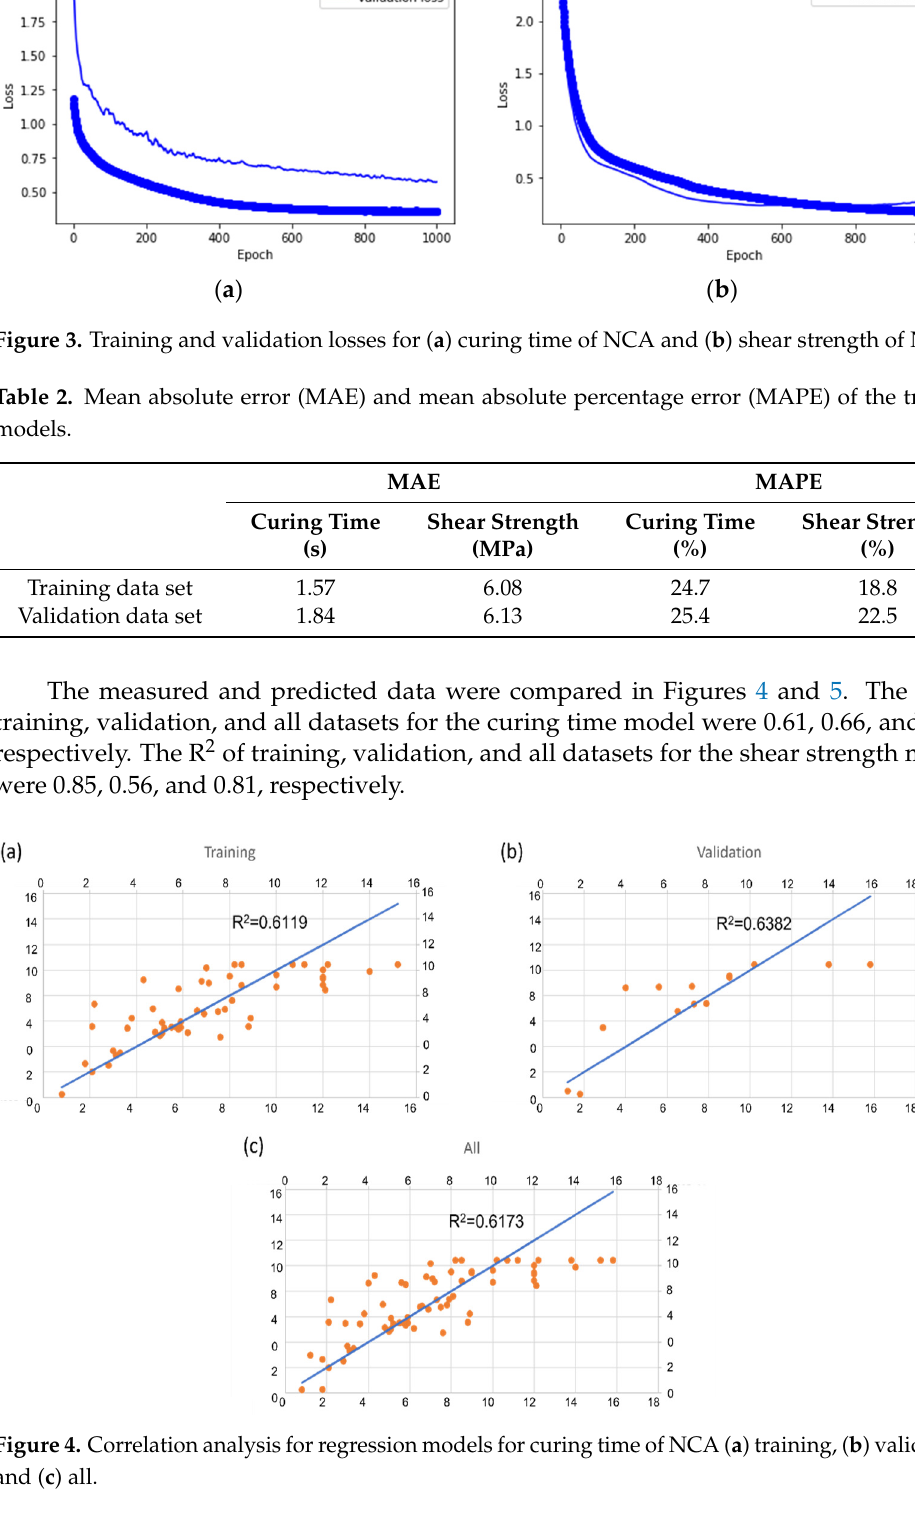
Figure 5. Correlation analysis for regression models for shear strength of NCA ( a ) training, ( b ) val- idation, and ( c ) all.